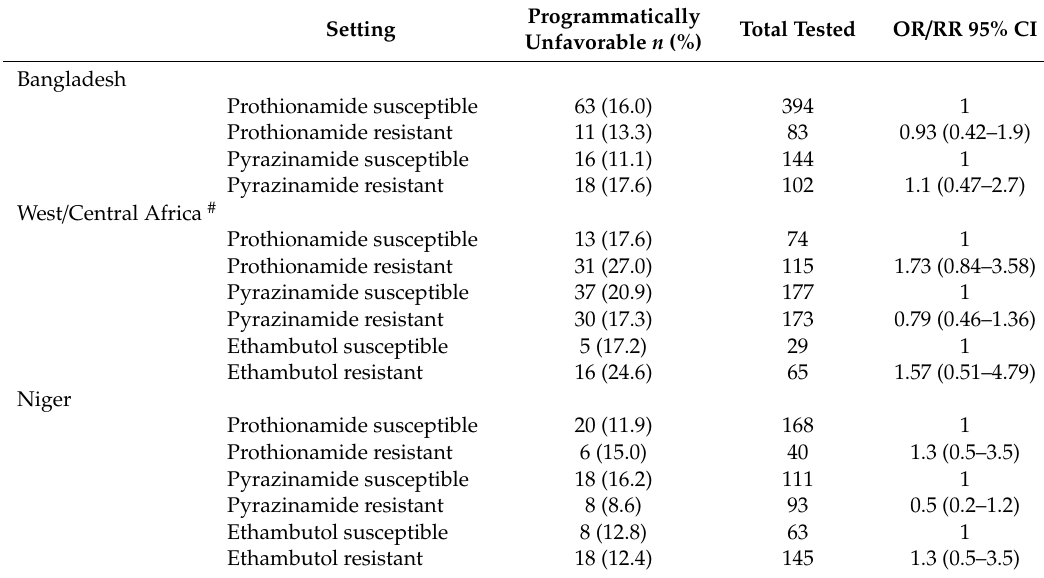
Table 4. Association between initial resistance to companion drugs and programmatically unfavorable outcome among patients with initially fluoroquinolone-susceptible tuberculosis (TB). Programmatically Setting Total Tested OR / RR 95% Unfavorable n (%)